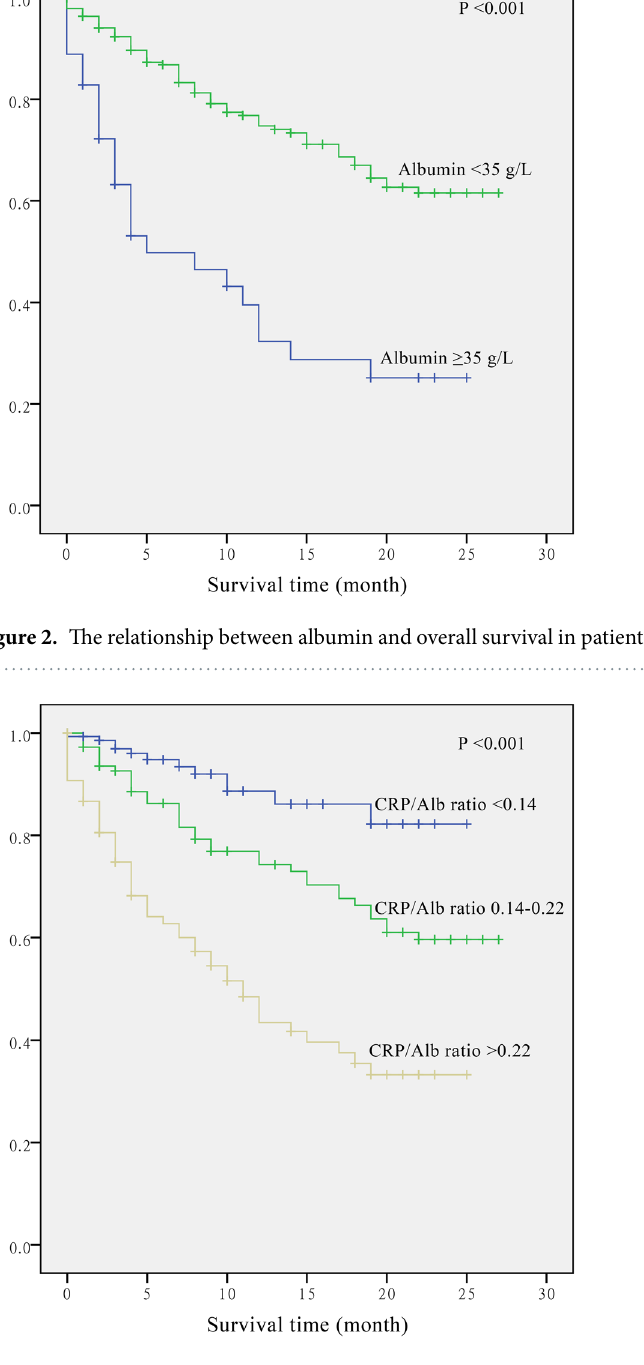
Figure 3. The relationship between C-reactive protein/Albumin (CRP/Alb) ratio and overall survival in patients with non-small cell lung